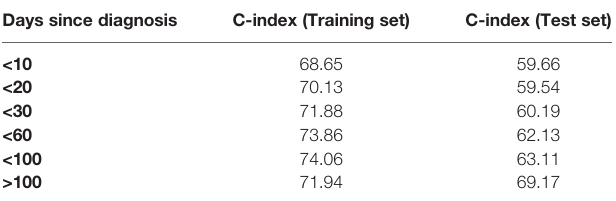
TABLE 1 | C-indexes of ST-123 after restricting the analysis to different time points since diagnosis. Days since